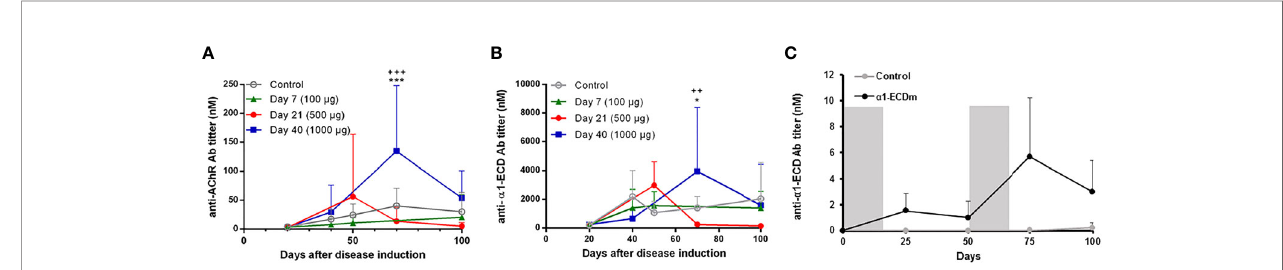
FIGURE 3 | Serum levels of rat AChR and a 1-ECD mt antibodies following intravenous administration of a 1-ECD mt . (A) Serum samples were collected at the indicated time points after disease induction from rats treated with 100 m g a 1-ECD mt on day 7 (N =, triangles), 500 m g on day 21 (N=7, circles), 1000 m g on day 40 (N = 6, squares), or PBS (N = 23, open circles), and were analyzed by RIPA for rat AChR antibodies. (B) The same serum samples as in (A) were assayed for a 1- ECD mt antibodies. (C) Healthy rats were injected with 500 m g a 1-ECD mt or PBS (N=10 for each group) during days 0 – 12 and days 50 – 62 as indicated by the gray bars, and serum samples collected at the indicated time points were analyzed for rat AChR and a 1-ECD mt antibodies (the lines show only a 1-ECD mt antibody titers, AChR antibodies were not detectable). In (A, B) * compares PBS vs Day 40, + compares Day 21 vs Day